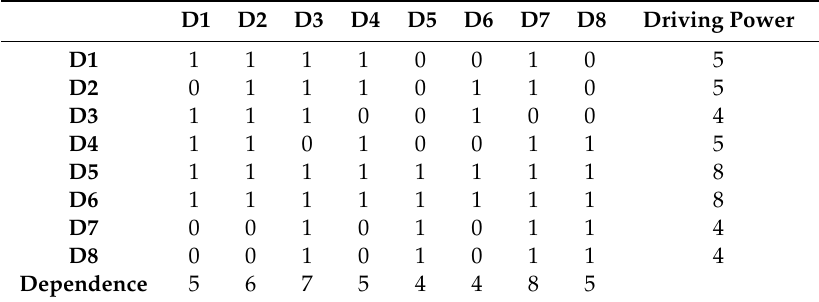
Table 6. Binary interaction matrix of the drivers of OSC.